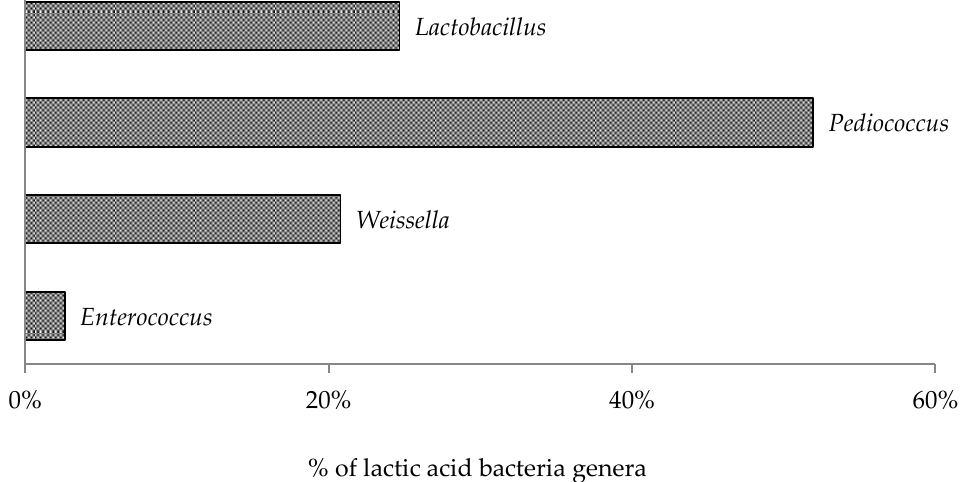
Figure 1. Frequency of lactic acid bacteria genera isolated from alfalfa silage through the fermentation period (56 days).